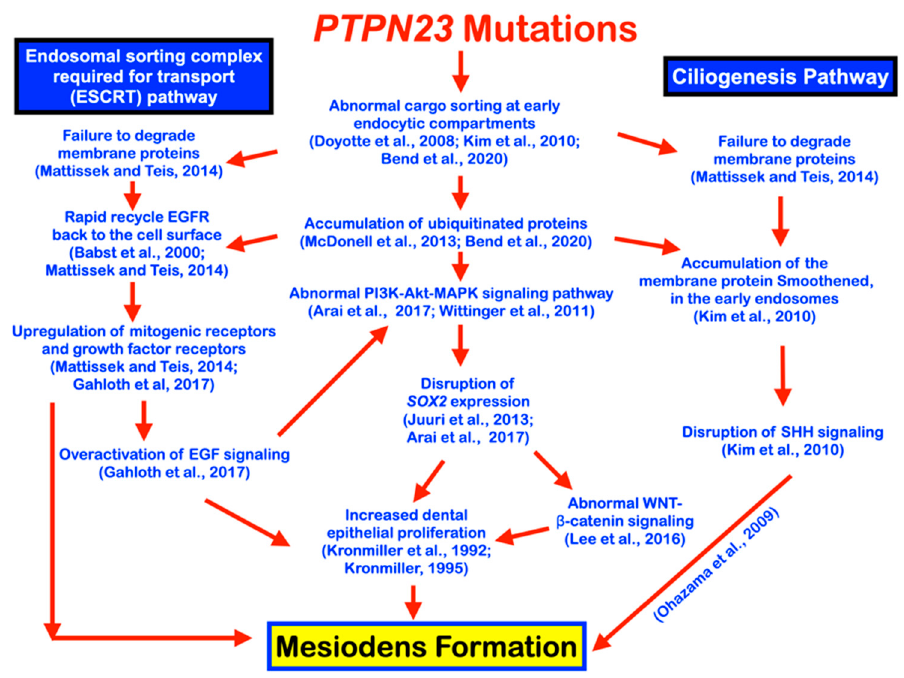
Figure 11. Proposed pathogenetic pathways as a result of PTPN23 mutations that lead to mesiodens formation. Refs: [59,62,70,72,73,77–85].